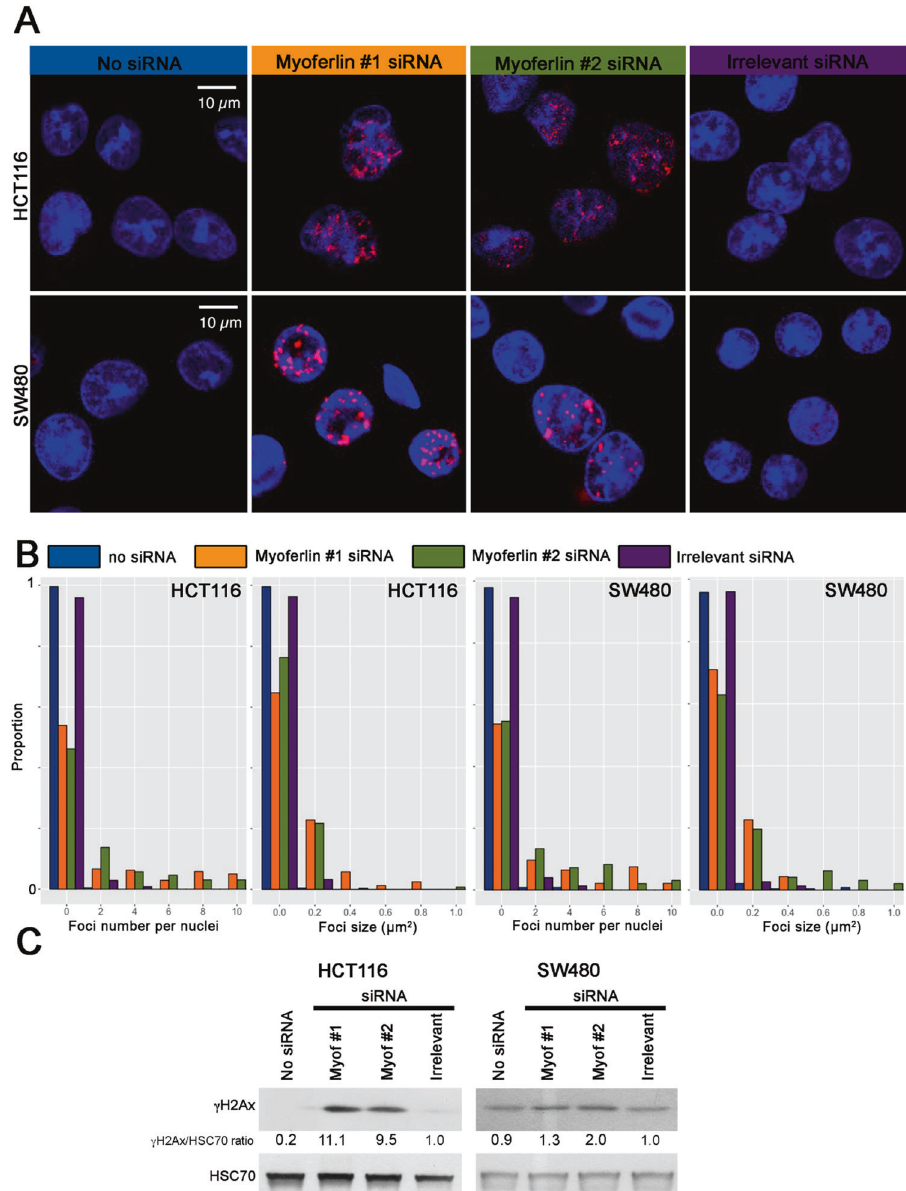
Fig. 5 Myoferlin-silencing induces a DNA damage response. a HCT116 and SW480 cell lines, silenced for myoferlin during 48h, were stained for γ H2Ax and observed under a confocal microscope. b γ H2Ax foci number and size were quanti fi ed using ImageJ. Number and size distributions were established ( n > 210 nuclei). c γ H2Ax abundance was evaluated by western-blot in HCT116 and SW480 48h after myoferlin silencing. Total protein extracts (10 μ g) were subjected to SDS-PAGE followed by western blot analysis with speci fi c antibodies. HSC-70 was used as a loading